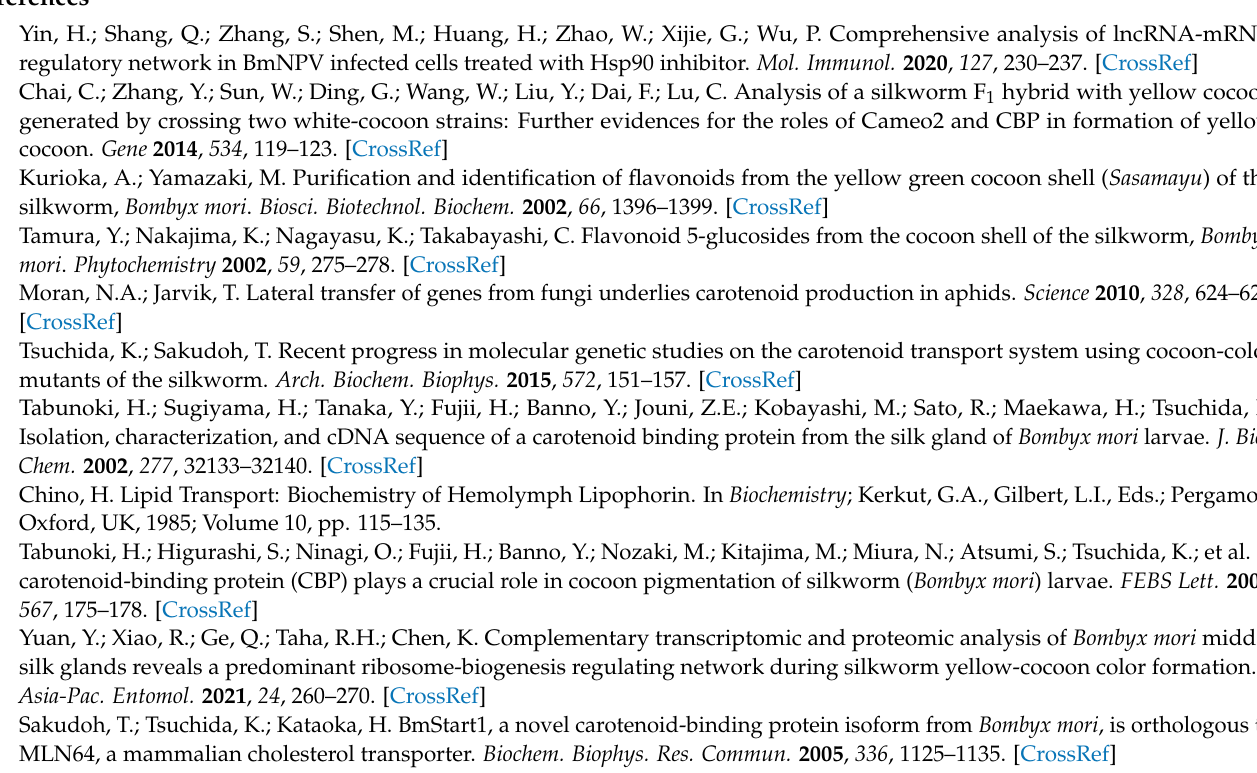
Table S8: The interaction network of DE-circRNAs-DE-miRNAs-DE-mRNAs; Table S9: The detailed primers information of the I gene and the